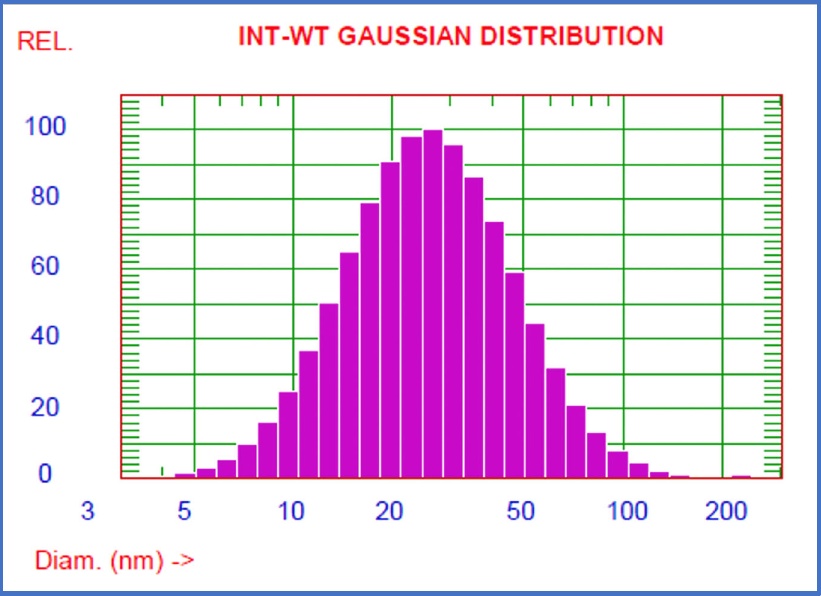
Figure 3. Size distribution of xanthohumol-loaded polymeric micelles based on Pluronics P123 and F127 (ratio 1:10). Mean diameter 30.5 ± 18.0 nm. Table 5. Changes of naringenin-loaded particle size against dilution with distilled water.